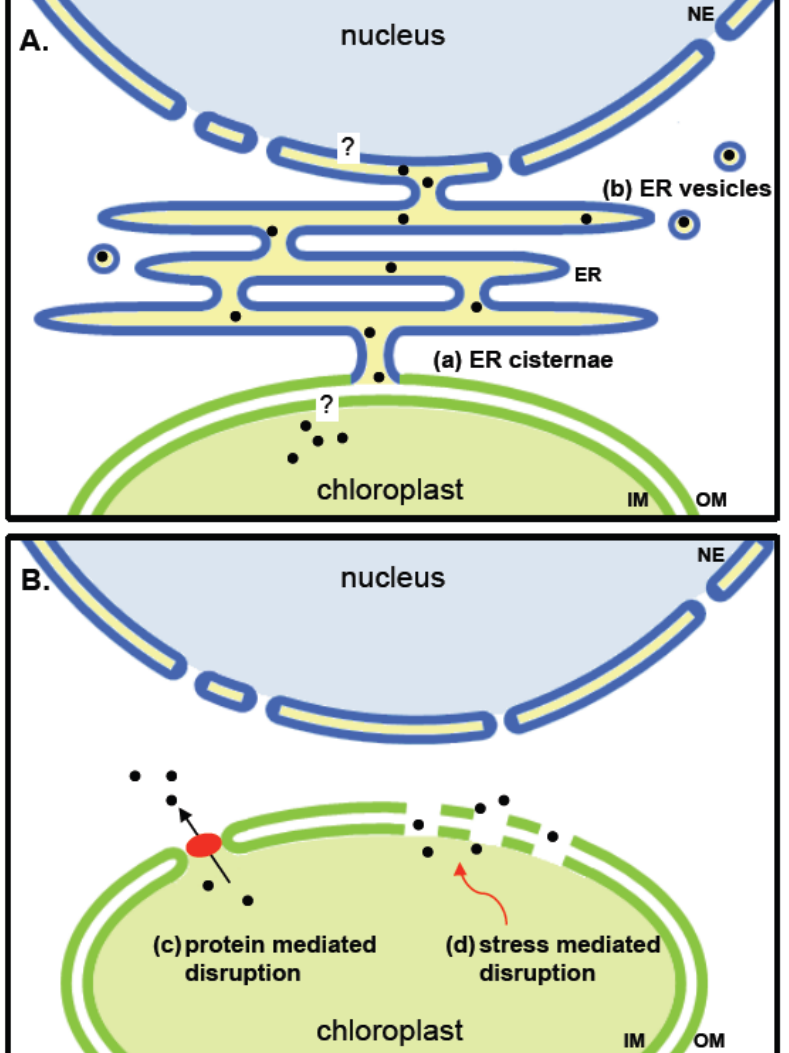
Figure 2. Selected mechanisms of protein translocation from chloroplasts to the nucleus. ( A ) Putative ER mediated transfer of plastid proteins to the nucleus. A periplasmic